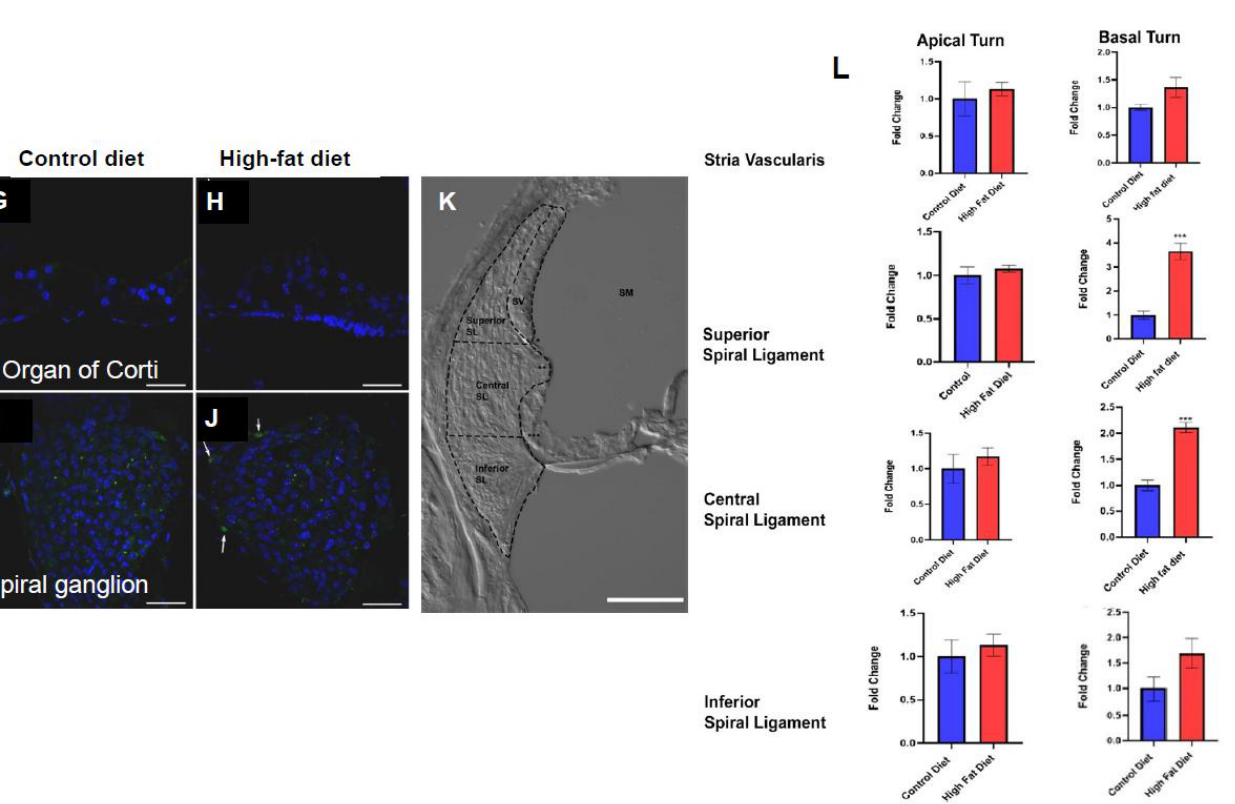
Figure 1. ICAM1 immunofluorescence in the mouse cochlea. ( A , D ). A low-level autofluorescence was observed in the stria vascularis in control cochlear cryosections where the primary antibody was replaced with the normal mouse IgG conjugated with Alexa 488. ( B , E ) In mice on a control diet (CD), weak ICAM1 immunostaining was observed in the spiral ligament (SL) and stria vascularis (SV) facing scala media (SM). ( C , F ) ICAM1 immunoexpression in the cochlear lateral wall (SV and SL) increased in intensity in mice on a high-fat diet (HFD). ( G – I ) ICAM1 immunofluorescence was not observed in the organ of Corti and the spiral ganglion of mice on CD. ( J ) Mice on HFD showed localised ICAM1 fluorescence in the spiral ganglion mostly around blood vessels (arrows). ( K ) Demarcations of the lateral wall used for semi-quantitative analysis of ICAM1. ( L ) Relative fold differences in ICAM1 immunostaining intensity in the lateral wall of the apical and basal cochlear turns. Data presented as mean ± SEM ( n = 5 per diet group). *** p < 0.001, t -test. Scale bars, 50 µ m. Blue, DAPI; Green, ICAM1